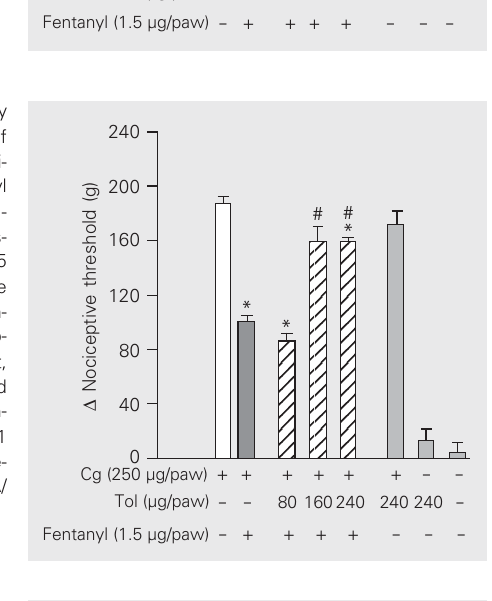
+Figure 3. Antagonism induced by intraplantar administration of gli- benclamide of the peripheral anti- nociception produced by fentanyl in hyperalgesic paws. Glibencla- mide (Gli, µg/paw) was adminis- tered 5 min before fentanyl (1.5 µg). Each column indicates the mean ± SEM (N = 5). The sym- bols “–” and “+” indicate the ab- sence and presence of treatment, respectively. *P < 0.01 compared to carrageenan (Cg) + vehicle-in- jected controls and # P < 0.01 compared to Cg + fentanyl + ve- hicle-injected controls (ANOVA/ Bonferroni’s